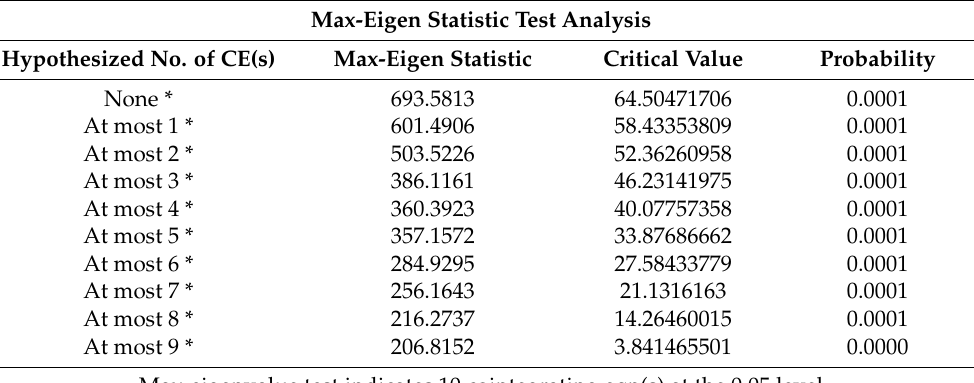
Table 4. Results from Johansen’s co-integration analysis: Max Eigen